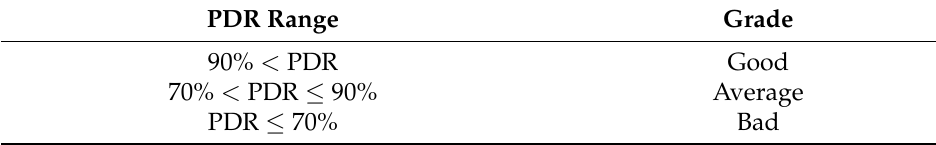
Table 6. Evaluation criteria of PDR.